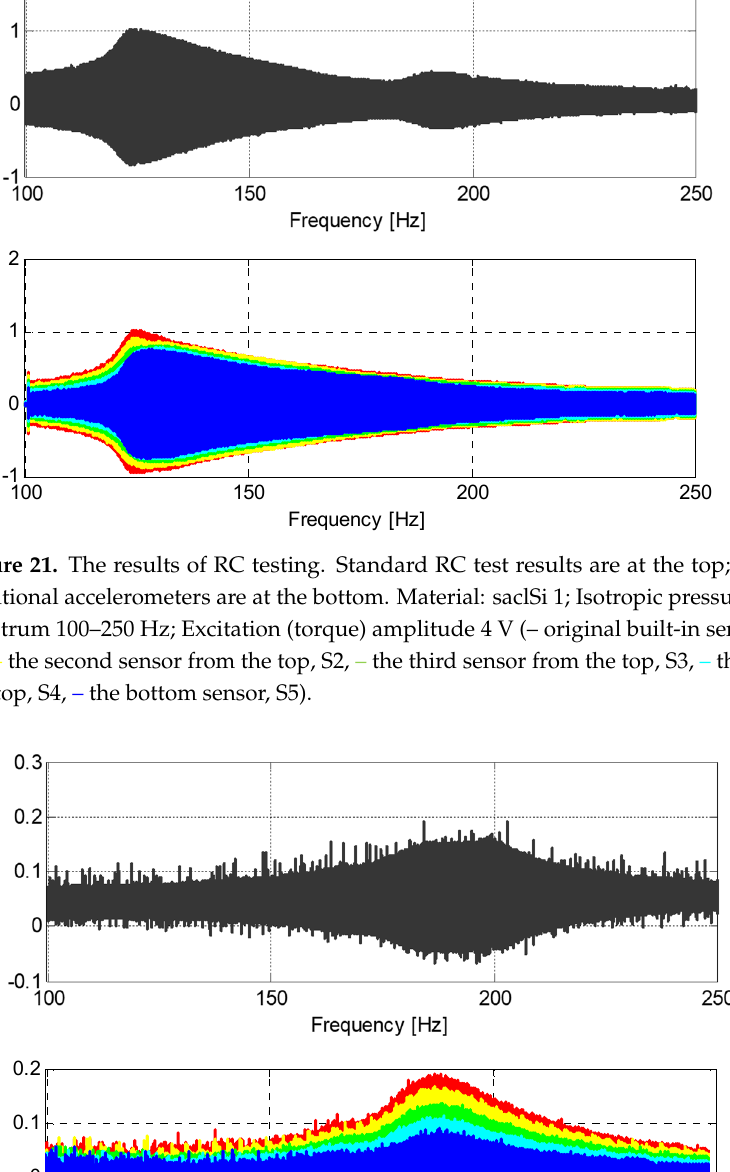
Figure 20. The results of RC testing. Standard RC test results are at the top; the results from the additional accelerometers are at the bottom. Material: saclSi 1; Isotropic pressure 50 kPa; Frequency spectrum 100–250 Hz; Excitation (torque) amplitude 2 V (– original built-in sensor, – the top sensor, S1, – the second sensor from the top, S2, – the third sensor from the top, S3, – the fourth sensor from the top, S4, – the bottom sensor, S5).